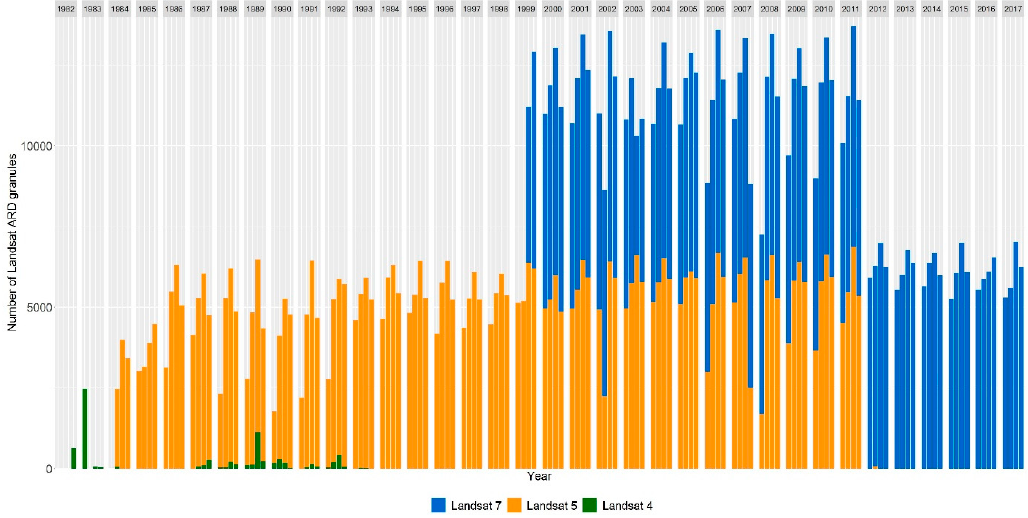
Figure 3. Seasonal number of Landsat ARD granules over the CONUS over the 36-year study period shown in order of winter (December to February), spring (March to May), summer (June to August) and autumn (September to November) for each year. The sensor count data (colored bars) are shown stacked on top of each other in periods with overlapping sensor data.